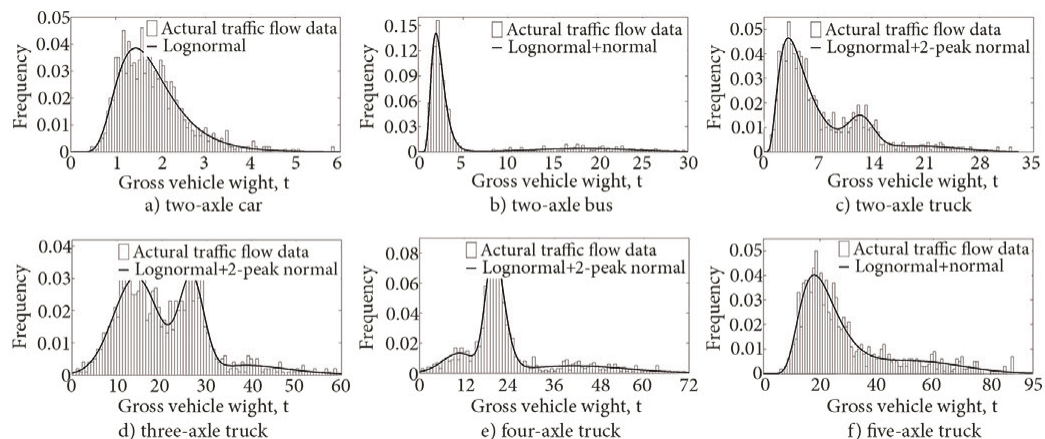
Fig. 3. Fitted probability density curve of different types of vehicle loads in fast